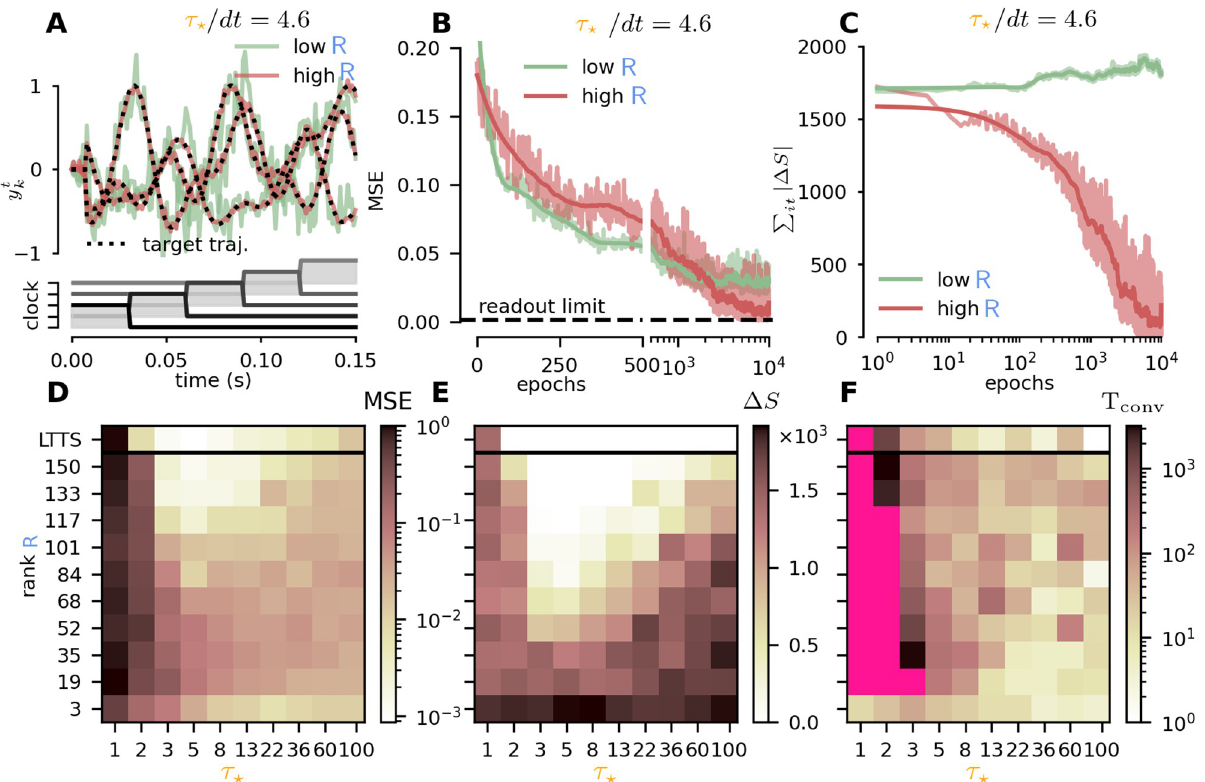
Fig 2. Parameter exploration. ( A ) We benchmarked our framework on a store and recall task. The network has to autonomously reproduce a target 3D trajectory, given a clock like input (bottom). Dashed line: target output. Solid line: network output at the end of the training for low and high rank conditions (green and blue respectively). ( B ) MSE (between the target output and the network output) as a function of training epochs, in the store and recall task of a 3D trajectory. Low rank (R = 3, green) and high rank (R = N, red) performances are compared. ( C ) Spike error of training epochs, for high and low rank learning rule. ( D ) The MSE (color-coded) as a function of the rank R and the timescale τ ? . ( E ) The spike error (color-coded) as a function of the rank R and the timescale τ ? . ( F ) Convergence time (color-coded) as a function of the rank R and the timescale τ ? .